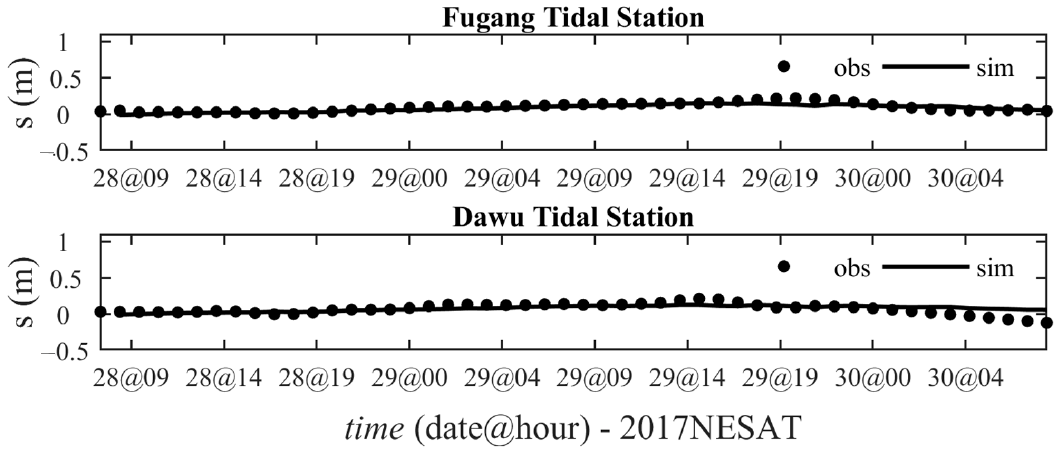
Figure 7. Comparisons of significant wave heights between model hindcasts and observations (Typhoon Meranti September 2017). Refer to Figure 5 for observation site locations.